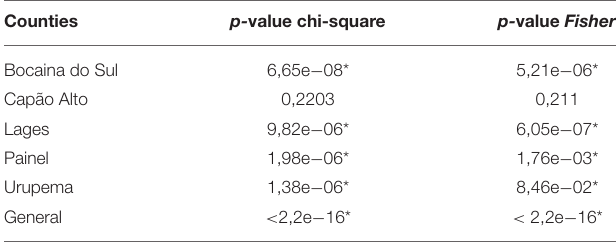
TABLE 4 | Comparison between the prevalence of bovine fasciolosis in vivo with the post mortem positivity index through chi-square and Fisher’s exact test in the municipalities of Bocaina do Sul, Capão Alto, Lages, Painel and